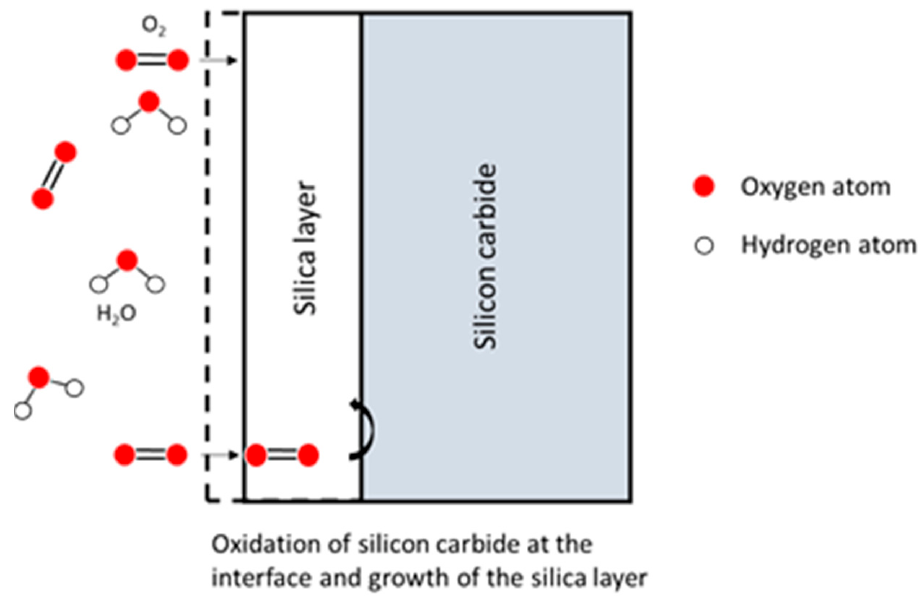
Figure 3. Scheme of the chemical reaction at the interface. 4. Transport of product gases (CO, CO 2 ) (Figure 4)